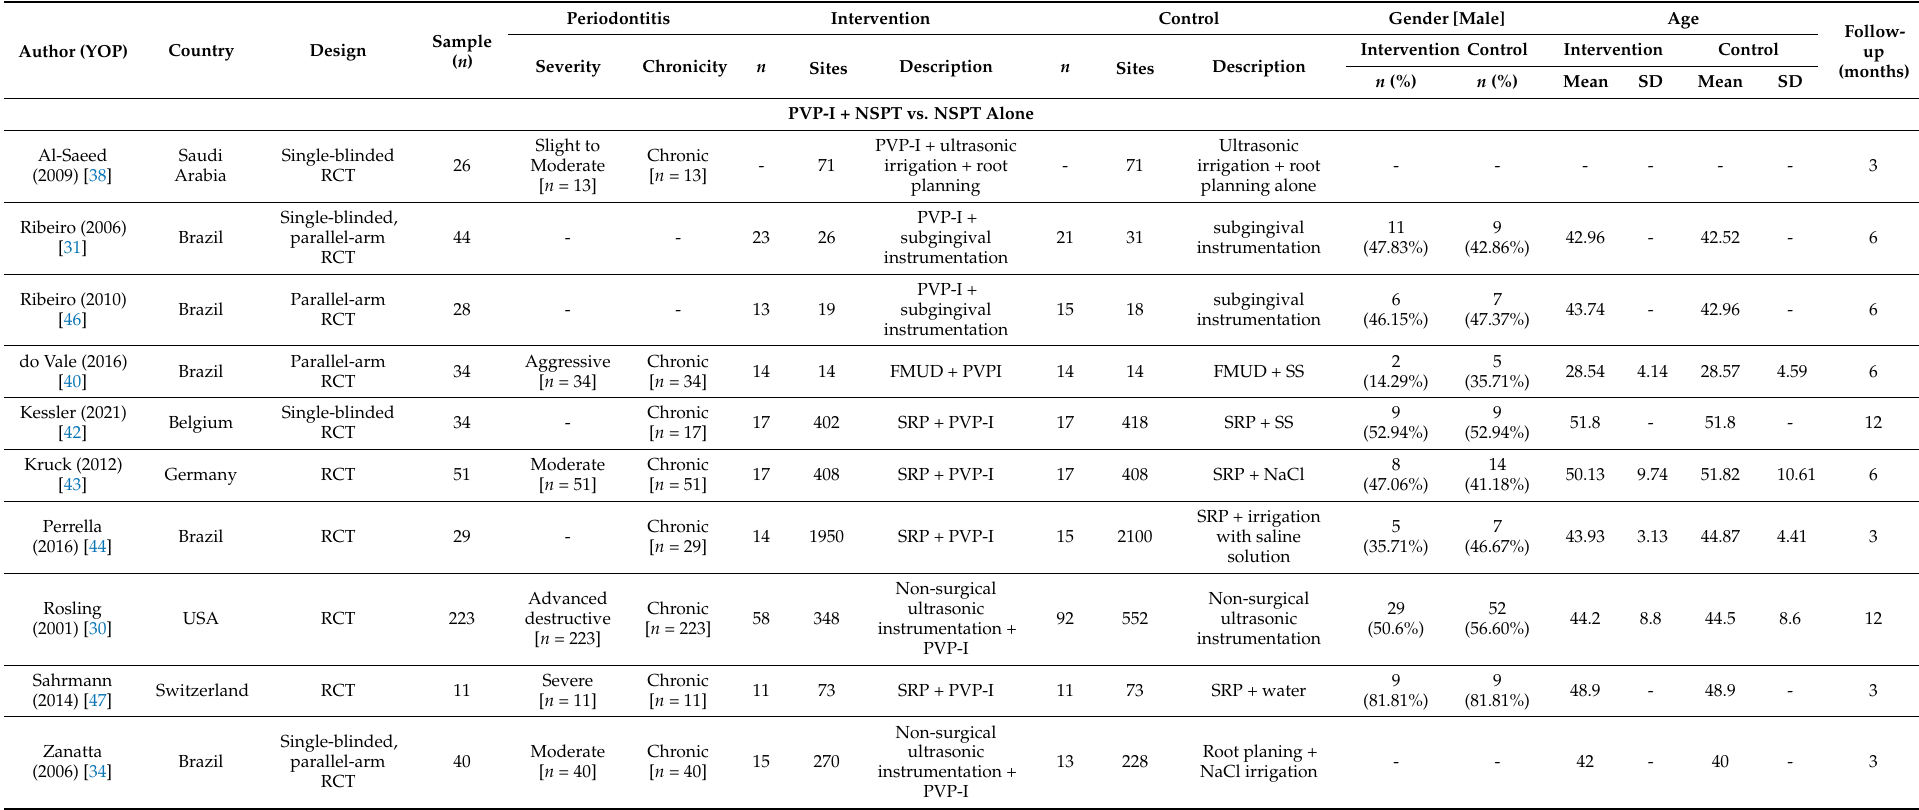
Table 1. Baseline characteristics of included studies reporting the use of PVP-I or NaOCl as an adjuvant to non-surgical debridement in periodontitis ( n =